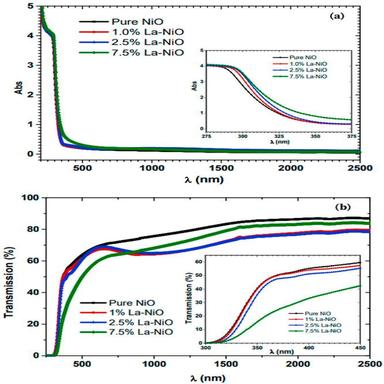
(a) Absorption and (b) transmittance versus wavelength of pure and La doped thin films.